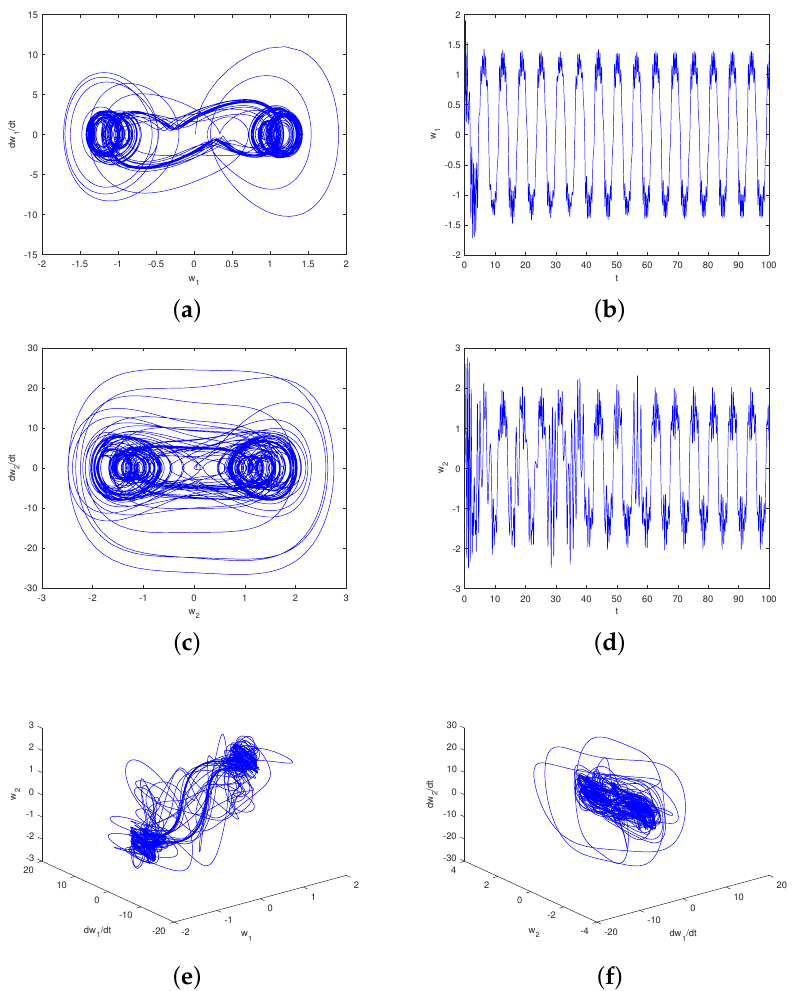
Figure 2. The phase portraits and waveforms of the sandwich plate with truss core when µ = 0.4 ) ; ( b ) the waveform on plane ( t , w ) ; ( c ) the and f = 13.3: ( a ) the phase portrait on plane ( w 1 , dw 1 1 dt ) ; ( d ) the waveform on plane ( t , w ) ; ( e ) the phase portraits in phase portrait on plane ( w 2 , dw 2 2 dt the three-dimensional space ( w 1 , dw 1 , w 2 ) ; ( f ) the phase portraits in the three-dimensional space dt ( dw 1 ) , w 2 , dw 2 dt dt